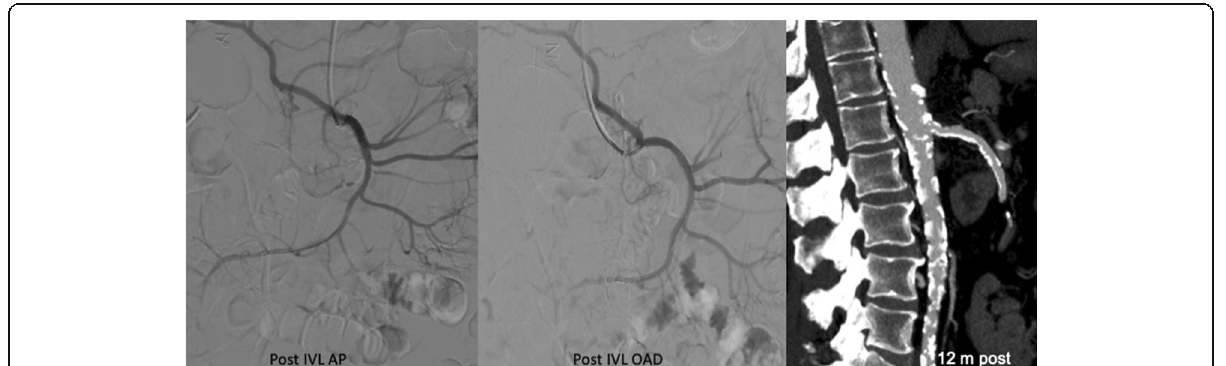
Fig. 3 Control arteriography post-treatment with IVL, and MPR of CTA 12 months